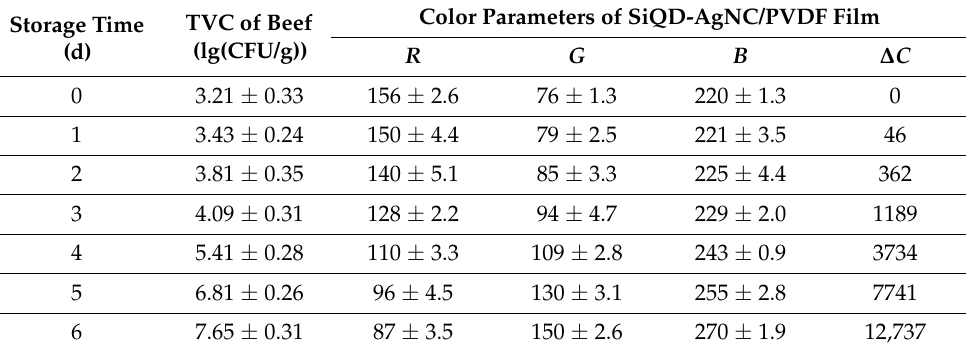
Figure 8. ( A ) The visible light photos and ( B ) fl uorescent light photos of a polypropylene packaging box integrated with a SiQD − AgNC/PVDF fi lm, during storage at 4 °C. ( C ) The fl uorescent light pho- box integrated with a SiQD-AgNC/PVDF film, during storage at 4 ◦ C. ( C ) The fluorescent light tos of the packaging system with beef sample, during storage at 4 °C. ( D ) The change of TVC values photos of the packaging system with beef sample, during storage at 4 ◦ C. ( D ) The change of TVC of beef during storage at 4 °C. ( E ) The relation between ∆ C of SiQD − AgNC/PVDF fi lm and TVC values of beef during storage at 4 ◦ C. ( E ) The relation between ∆ C of SiQD-AgNC/PVDF film and value of beef. TVC value of beef. Table 3. The R , G , B values of fluorescent light photos of the SiQD-AgNC/PVDF film during beef